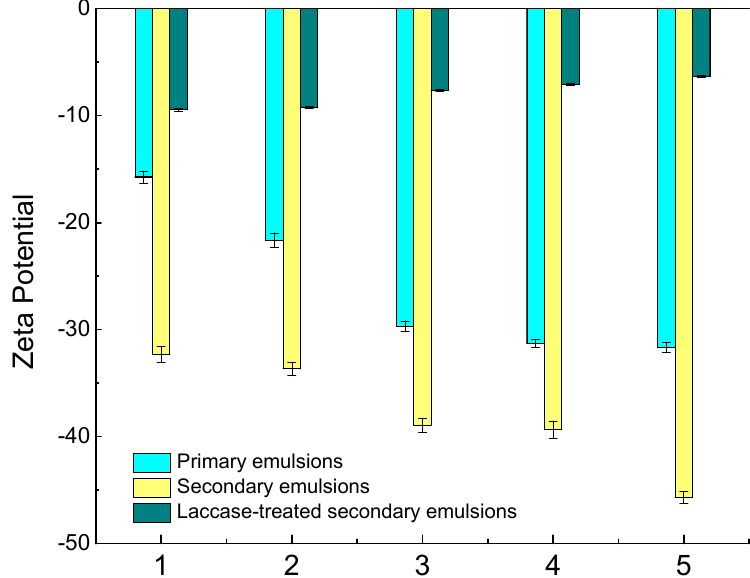
Figure 2. Zeta potential of primary emulsions (1, 2, 3, 4, and 5 represent protein content of 0.8 g/100 g, 1.8 g/100 g, 2.8 g/100 g, 3.8 g/100 g, and 4.8 g/100 g, respectively); secondary emulsions (protein content was 3.8 g/100 g, and 1, 2, 3, 4, and 5 represent SBP content of 0.01 g/100 g, 0.02 g/100 g, 0.05 g/100 g, 0.10 g/100 g, and 0.15 g/100 g, respectively); laccase-treated secondary emulsions (protein content was 3.8 g/100 g, SBP content was 0.10 g/100 g, and 1, 2, 3, 4, and 5 represent laccase content of 2 U/100 g, 4 U/100 g, 6 U/100 g, 8 U/100 g, and 10 U/100 g, respectively).